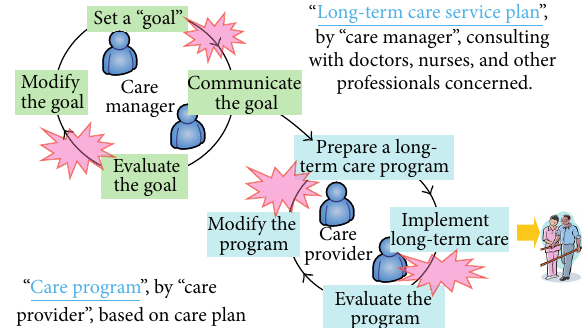
Figure 1: Management system under the Long-term Care Insurance